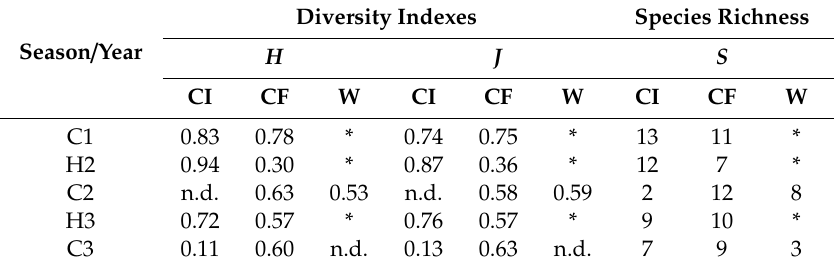
Table 2. Diversity indexes of AMF communities colonizing roots of C. indica (CI), C. flaccida (CF), and W. borbonica (W) inhabiting a constructed wetland (CW) during cold (C) and hot (H) seasons across three consecutive years (1, 2, and 3). H — Shannon-Wienner index; J — Pielou index; S — Species richness.